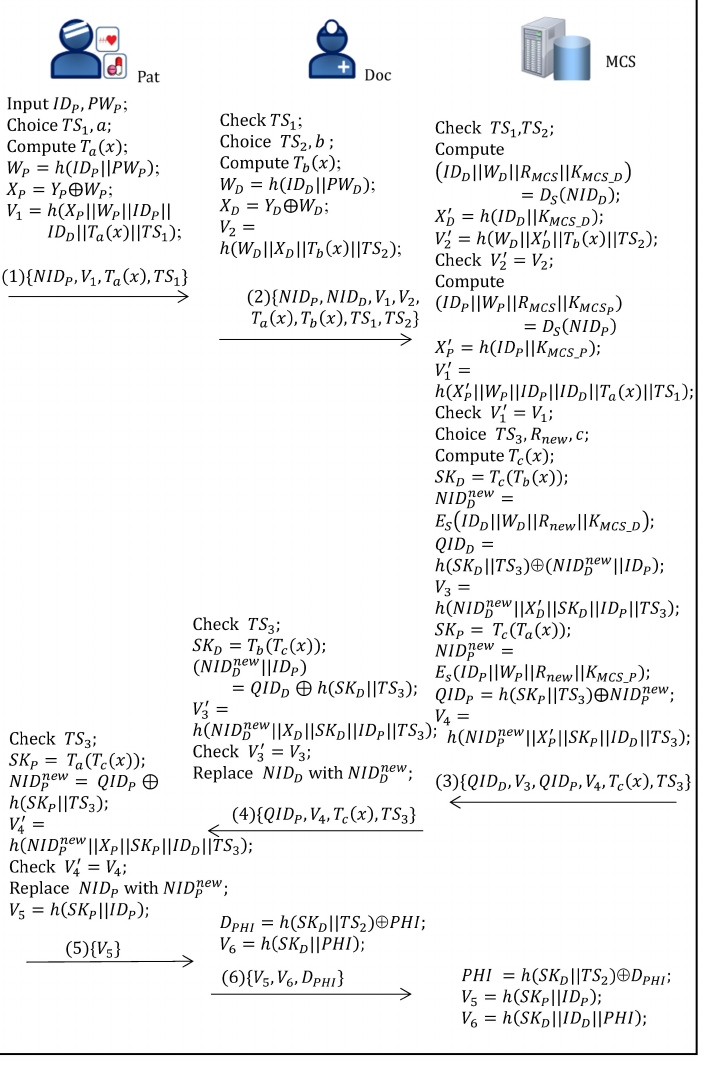
Figure 1. The processes of PHI upload phase of the proposed